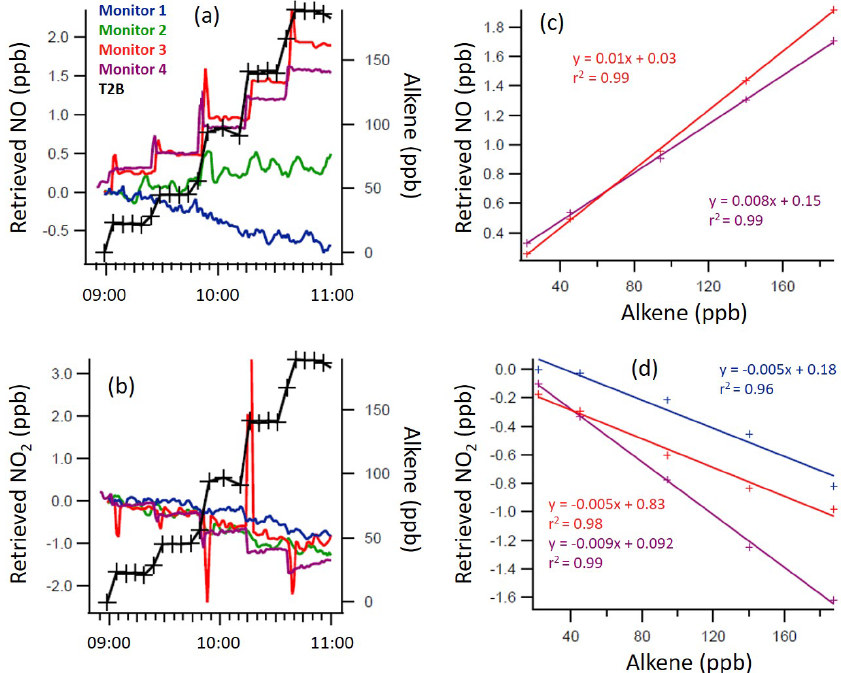
Figure 4. Time series of the trans-2-butene (T2B) mixing ratio and measured NO (a, c) and NO 2 (b, d) mixing ratios, as retrieved by each monitor (a, b) , with 1min time resolution, and the regression calculations for the monitors that demonstrated significant interference with the addition of T2B (c, d) . Note the different y axis